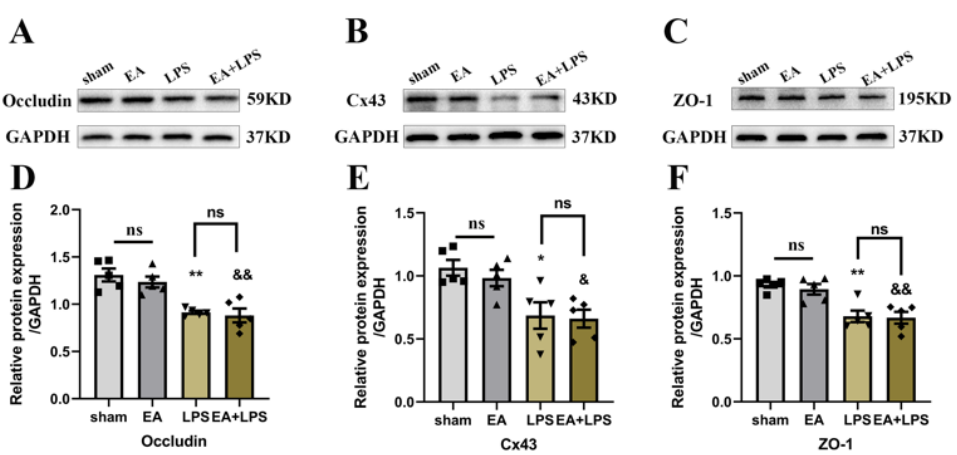
Figure 8. EA was ineffective in the junction proteins of the BBB: n = 5 per group. ( A ) Representative blots of Occludin. ( B ) Representative blots of Cx43. ( C ) Representative blots of ZO-1. ( D ) Quantifi- cation of the expression level of Occludin. ( E ) Quantification of the expression level of Cx43. ( F ) Quantification of the expression level of ZO-1. Data are presented as means ± SEM. Compared with the sham group, ** p < 0.01, * p < 0.05, && p < 0.01, & p < 0.05. , , , : Represents the individual value of the rats in each group. Abbreviations: Cx43, connexin 43; ZO-1, zonula occludens-1; GAPDH, glyceraldehyde 3-phosphate dehydrogenase; EA, electroacupuncture; LPS, lipopolysac- charide; ns, no significant difference.